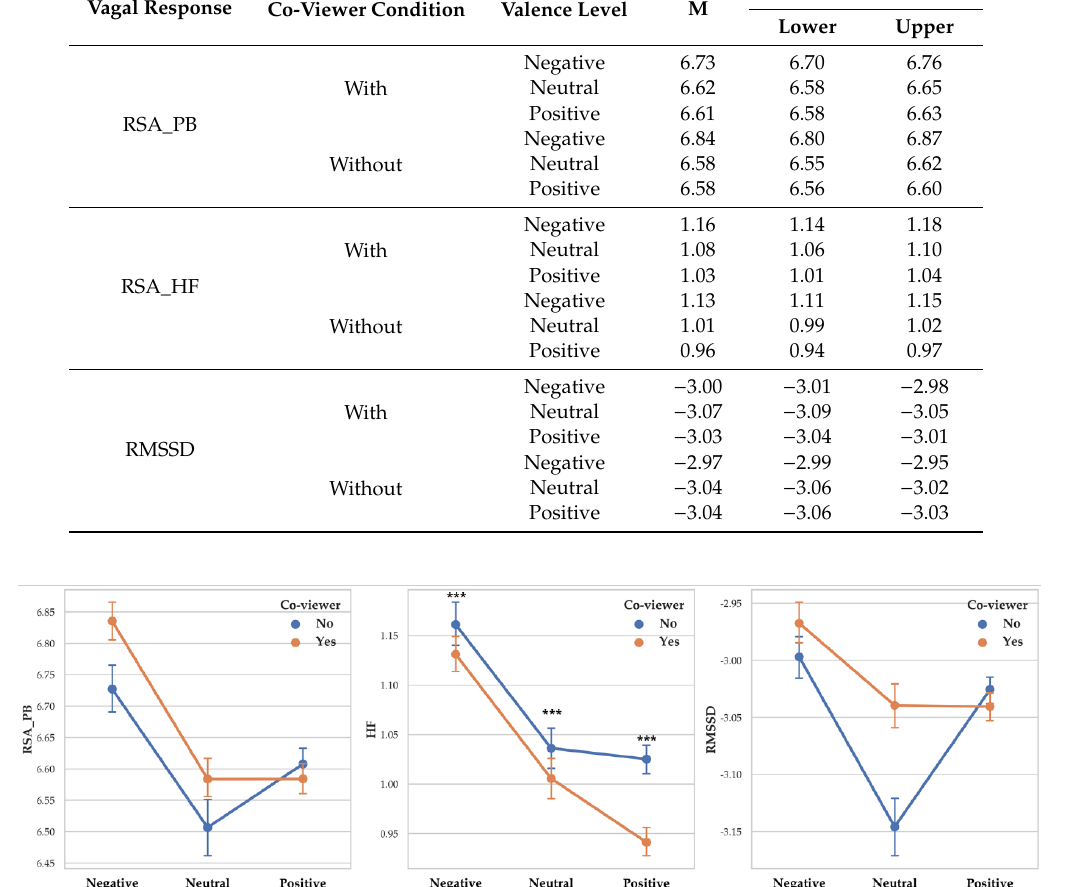
Figure 14. Point graph of vagal response depending on co-viewer condition and arousal level. Point means mean of vagal responses. Asterisk means significant vagal responses difference according to co-viewer condition. (***: p < 0.001).